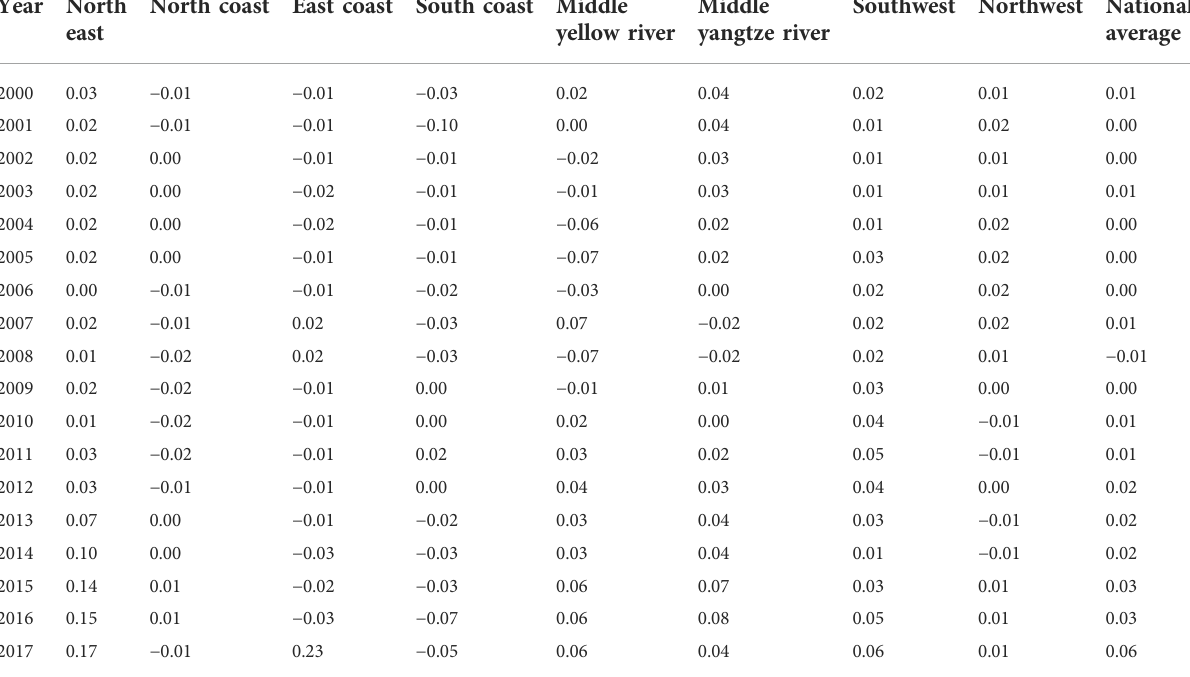
TABLE 1 The gap between China ’ s fossil energy ef fi ciency and clean energy ef fi